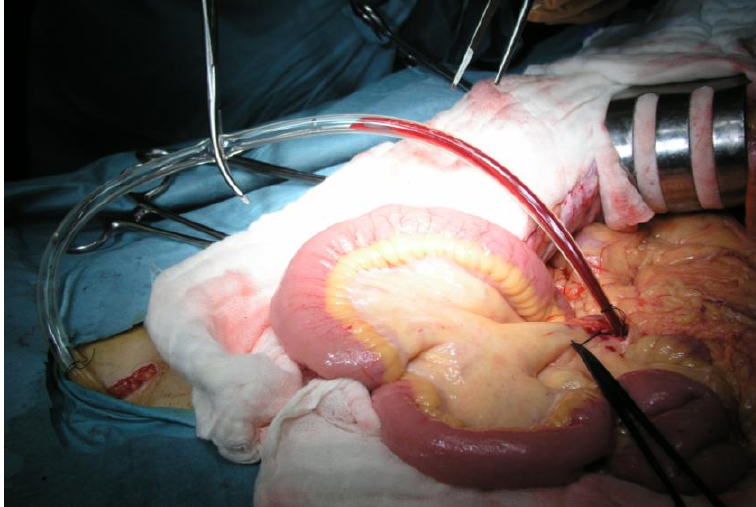
Figure 3. Photograph of catheter-bypass between the mesenteric and femoral veins. One end of the catheter is inserted in one of the branches of the superior mesenteric vein, and the other end in the femoral vein via the right greater saphenous vein. Portal venous blood flows into the femoral vein owing to the pressure differences between the portal and femoral